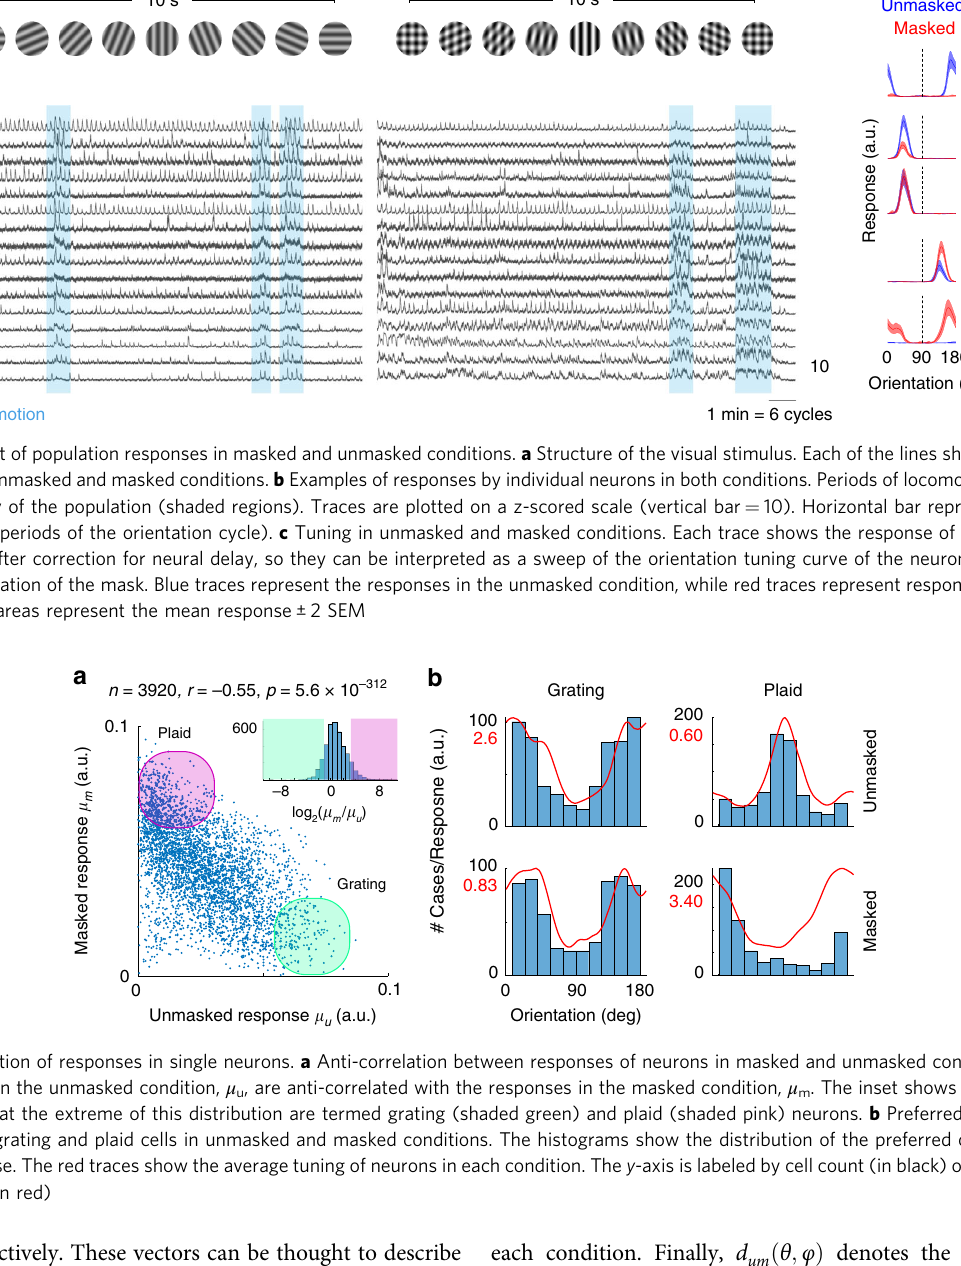
Fig. 2 Characterization of responses in single neurons. a Anti-correlation between responses of neurons in masked and unmasked conditions. The mean responses of cells in the unmasked condition, μ u , are anti-correlated with the responses in the masked condition, μ m . The inset shows the distribution of (cid:1) (cid:3) . Cells at the extreme of this distribution are termed grating (shaded green) and plaid (shaded pink) neurons. b Preferred orientation and log 2 μ m = μ u average tuning of grating and plaid cells in unmasked and masked conditions. The histograms show the distribution of the preferred orientation of the neurons in each case. The red traces show the average tuning of neurons in each condition. The y -axis is labeled by cell count (in black) or by the amplitude of the responses (in